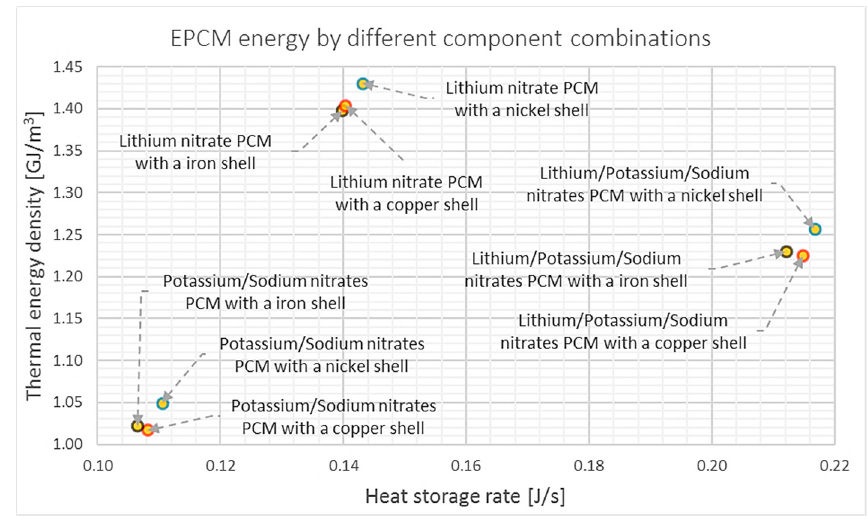
Figure 3. EPCMs thermal energy density and heat storage rate comparisons.